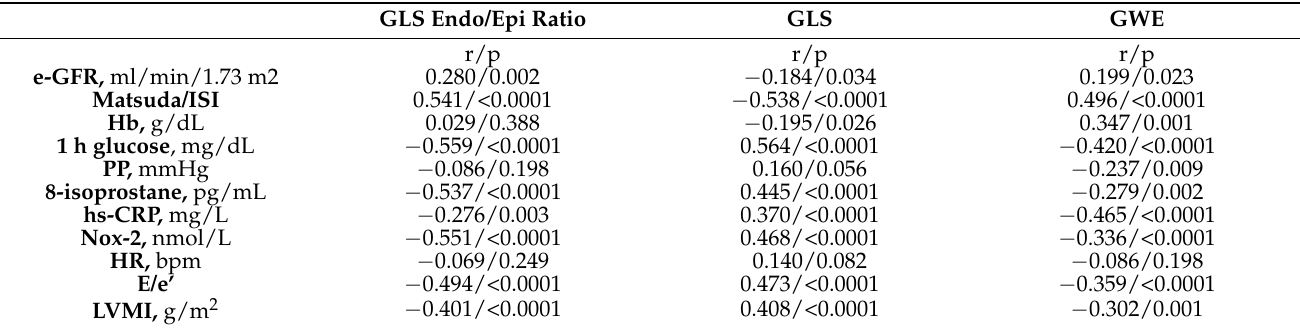
Table 3. Linear regression analysis between GLS endo/epi ratio, GLS, GWE, and different covariates in the whole study